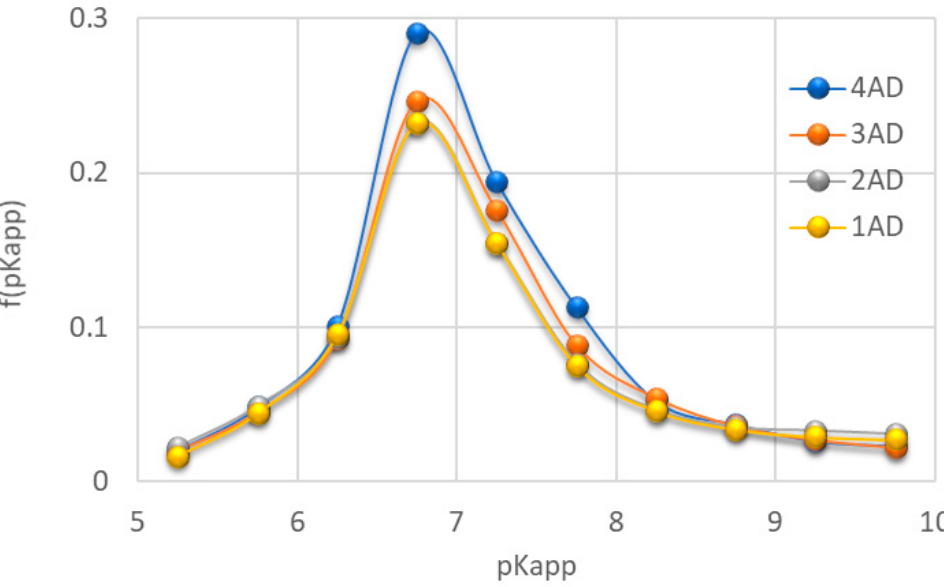
Figure 2. Distribution function of apparent dissociation constants for the studied teeth samples (1AD-incisors, 2AD-canines, 3AD-premolars, 4AD-molars).